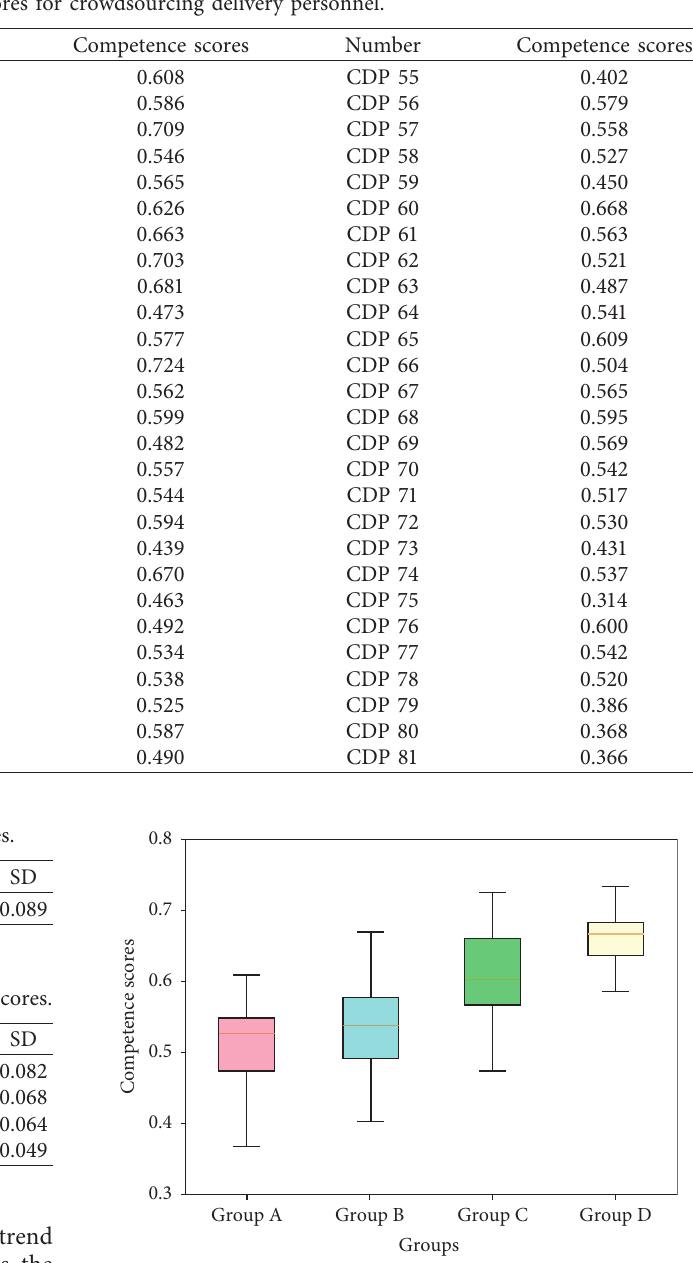
Table 4: Competence scores for crowdsourcing delivery personnel.